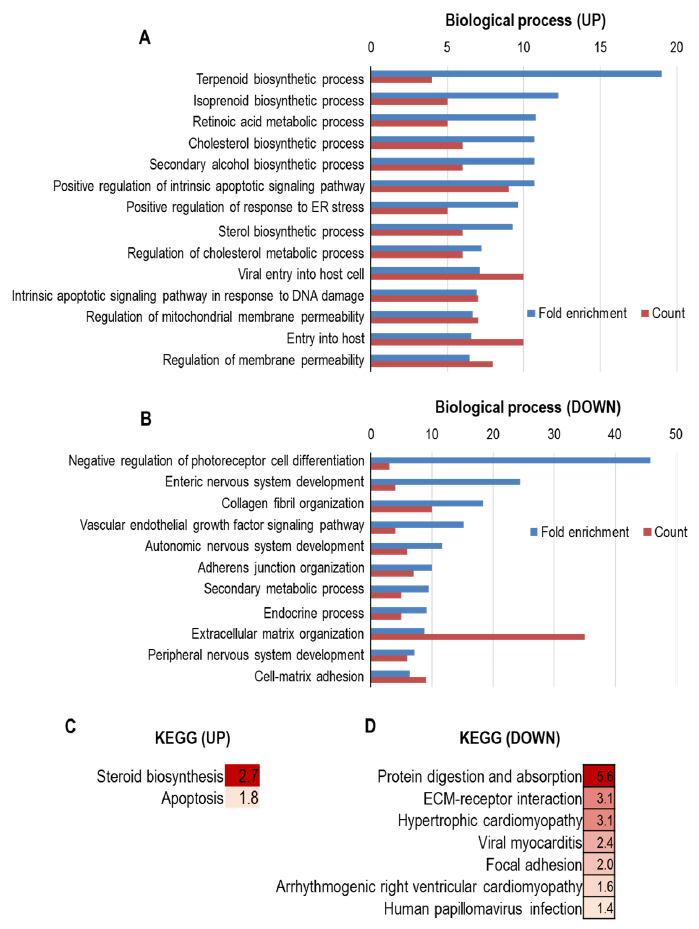
Figure 2. GO enrichment analysis and KEGG pathway enrichment analysis of differentially expressed genes by aging in human gingiva. ( A – D ) mRNA profiles of young and old human gingiva were extracted and analyzed from the NCBI Gene Expression Omnibus (GEO) profile database (GEO accession: GSE83382). Determination of upregulated genes during aging was based on fold-change of the expression level > 2 and a p -value < 0.05. Determination of downregulated genes was based on fold-change of the expression level < 0.5 and a p -value < 0.05. GO analysis of upregulated genes ( A ) and downregulated genes ( B ) was conducted by utilizing Gene Ontology re- sources [78–80]. KEGG pathway analysis of upregulated genes ( C ) and downregulated genes ( D ) was conducted by utilizing g:Profiler [81,82]. In ( C , D ), the color indicates the degree of statistical significance, and negative log10 of adjusted p values were presented in each box.